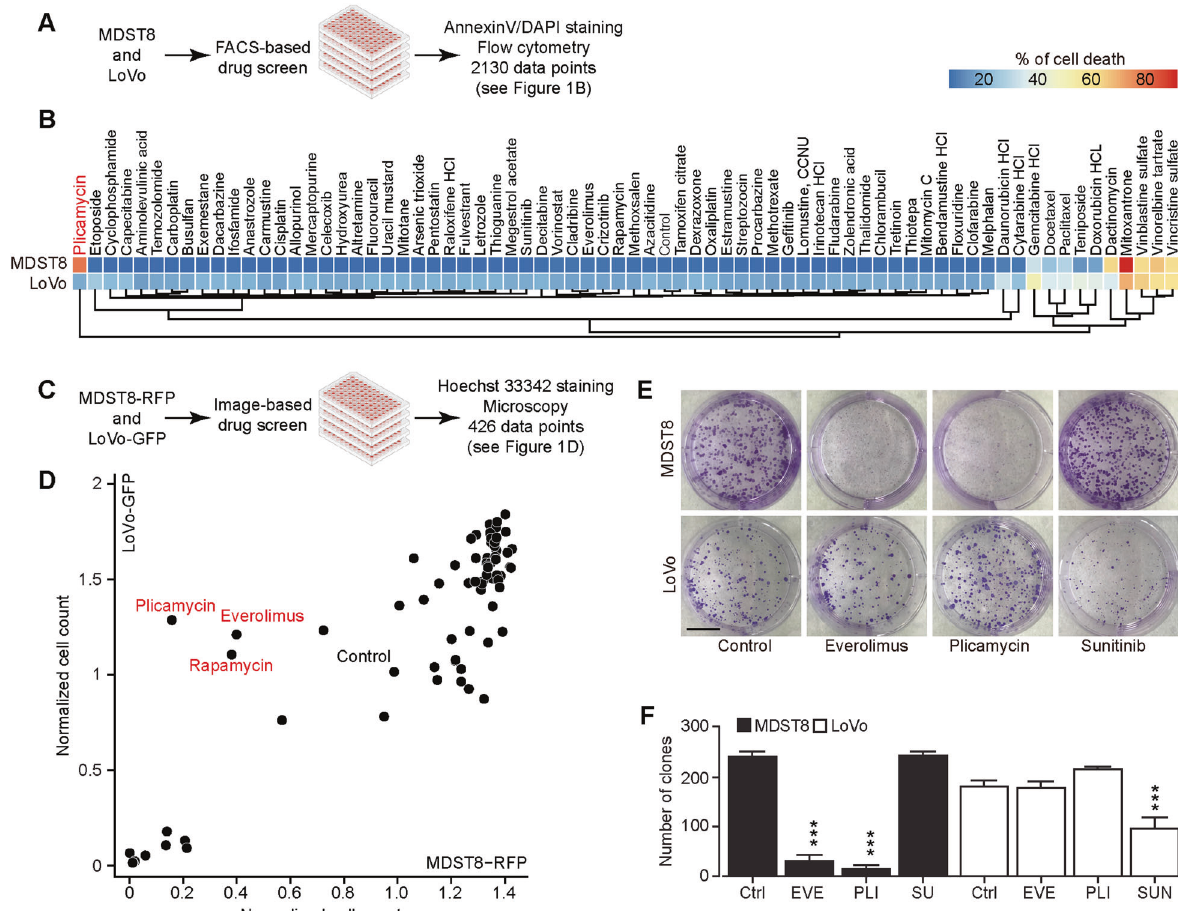
Fig. 1 Chemical compound screen discovers that plicamycin and everolimus speci fi cally target MDST8. A Scheme of the screening campaigns. B MDST8 or LoVo cells were treated with 71 drugs in the anticancer library at a concentration of 0.1 μ M for 72 h. The percentage of AnnexinV high DAPI high cells was measured by fl ow cytometry as an indicator for cell death. Each parameter depicts the mean value of three times repeated experiments and is depicted in a hierarchically clustered heatmap. The blue and red tiles in the heatmap represent the percentage of Annexin V high DAPI high death cells range from 0 to 100%. C Identi fi cation of plicamycin, everolimus, and rapamycin as chemicals that speci fi cally kill MDST8 but not LoVo cells. MDST8-RFP or LoVo-GFP cells were treated with 71 drugs in the anticancer library at